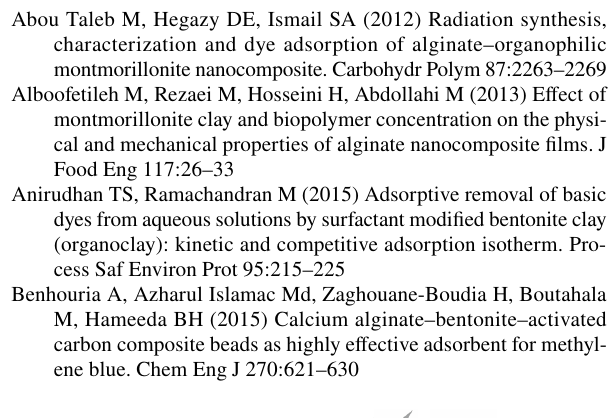
Fig. 11 Reuse of composite ( C V = 200 cm 3 , T = 20 °C, pH =